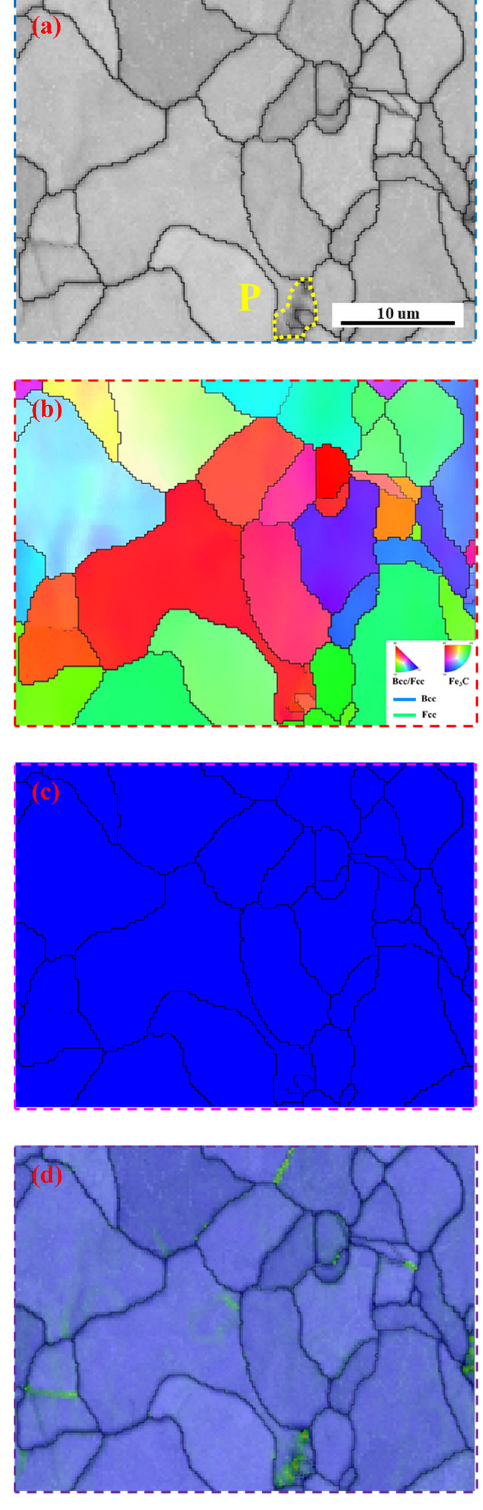
Fig. 4 EBSD patterns of microstructure of low-alloy steel Q500. a BC diagram, b IPF diagram, c Phase diagram, and d KAM diagram.